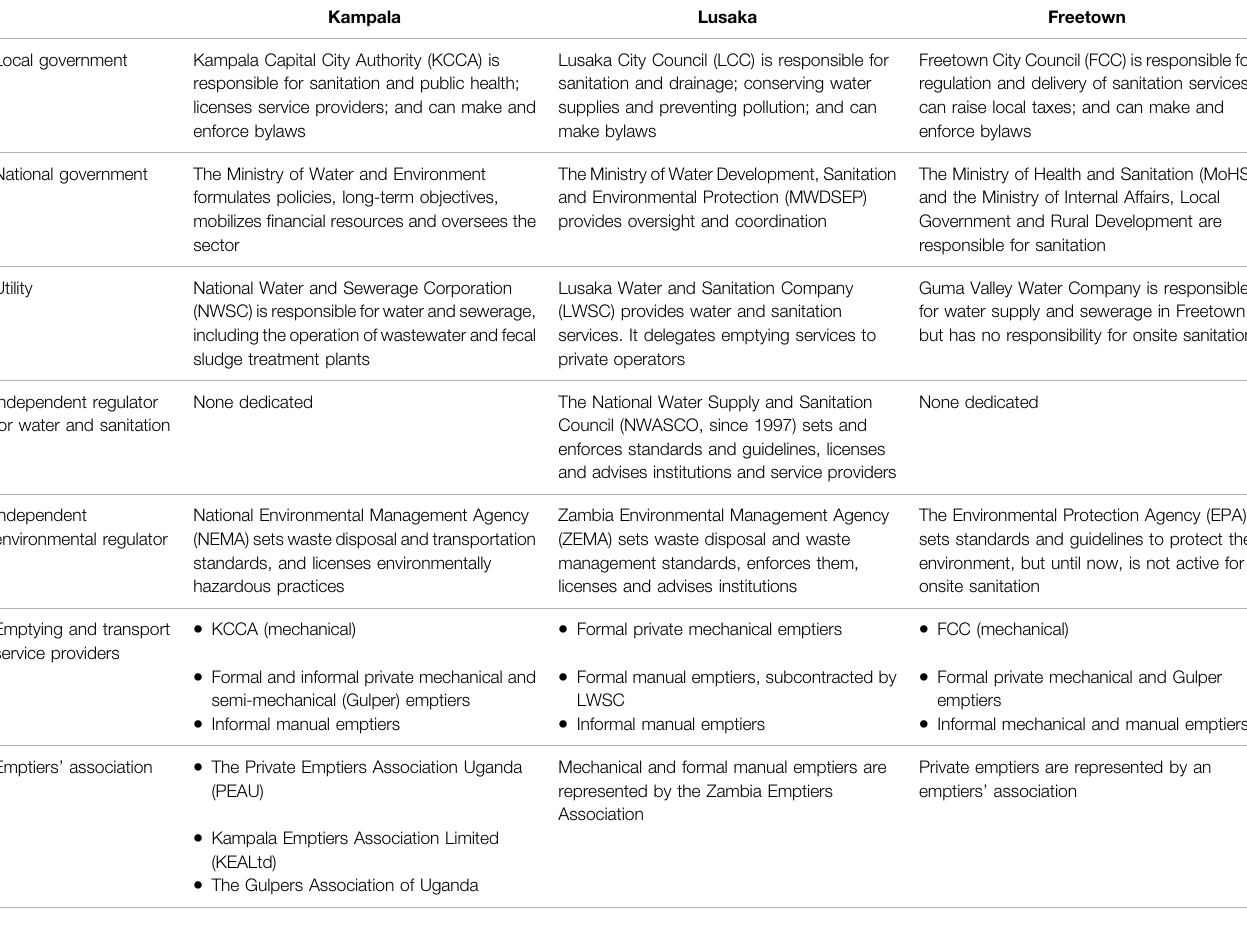
TABLE 3 | Main stakeholders involved in provision and regulation of emptying and transport services.